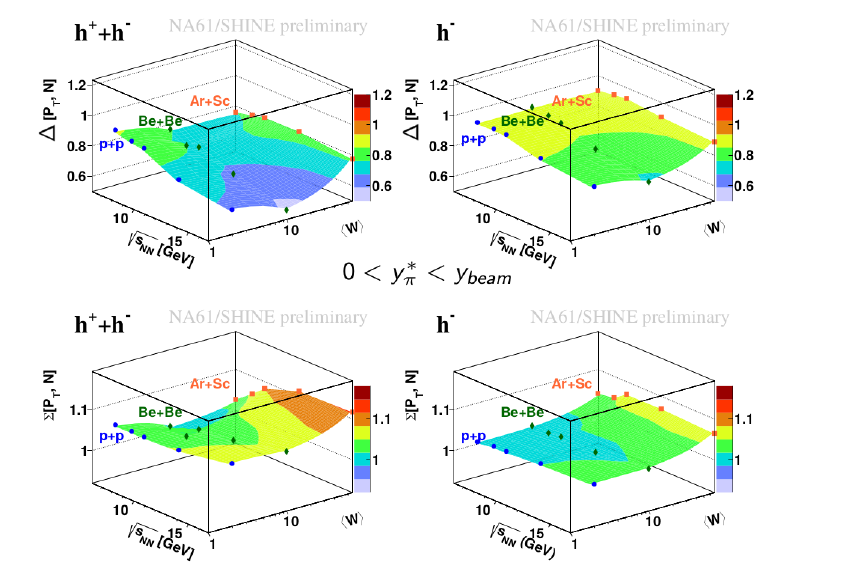
Figure 2. ∆ [ P T , N ] and Σ [ P T , N ] energy and system size dependence in p + p, Be + Be and Ar + Sc central collisions at beam momenta 20-150 / 158 A GeV / c.